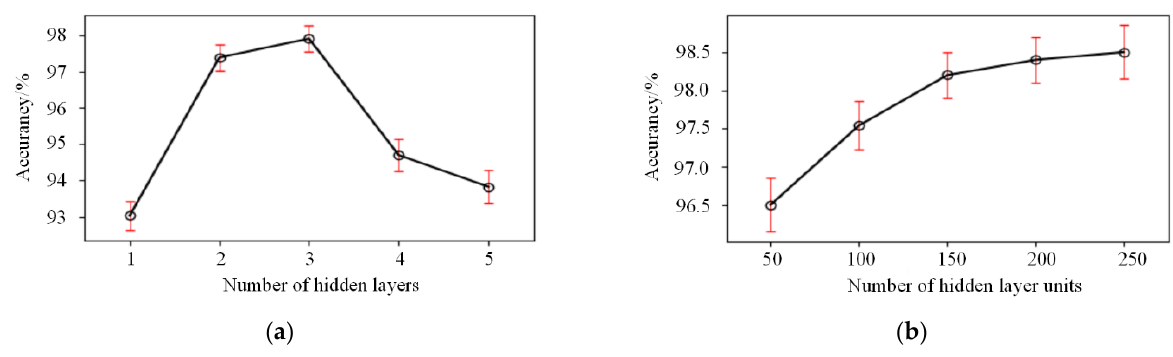
Figure 5. Fault diagnosis accuracy of DBN with the different number of hidden layers and number of units in the hidden layer. ( a ) Accuracy of DBN with different hidden layers. ( b ) Accuracy of DBN with different hidden units.